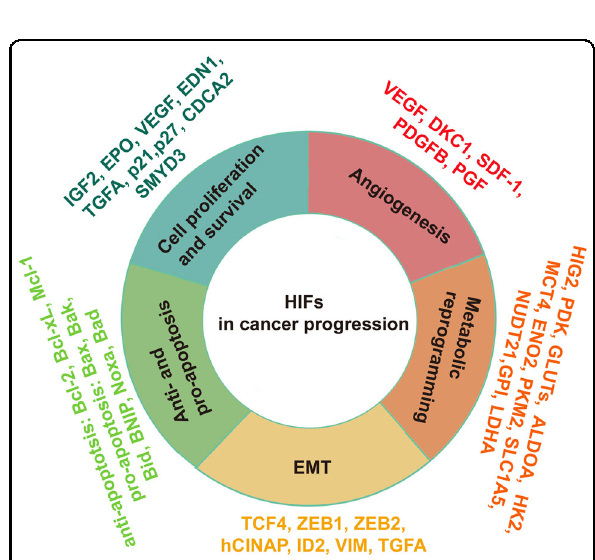
Fig. 2 Role of HIFs in cancer progression. HIFs have a wide range of target genes which function to manage different types of signaling pathways in cancer. As an example, HIFs modulate cellular metabolic reprogramming, cell proliferation and survival, angiogenesis, apoptosis, and